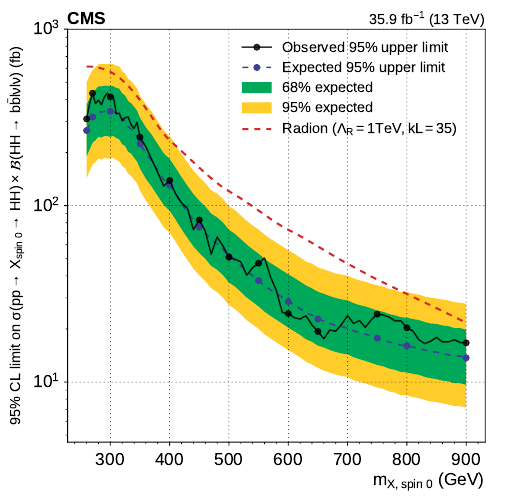
Figure 7 . Expected (dashed) and observed (continuous) 95% CL upper limits on the product of the production cross section for X and branching fraction for X ! HH ! bbVV ! bb ‘(cid:23)‘(cid:23) , as a function of m X . The inner (green) band and the outer (yellow) band indicate the regions containing 68 and 95%, respectively, of the distribution of limits expected under the background- only hypothesis. These limits are computed using the asymptotic CL s method, combining the e + e (cid:0) , (cid:22) + (cid:22) (cid:0) and e (cid:6) (cid:22) (cid:7) channels, for spin-0 (left) and spin-2 (right) hypotheses. The solid circles represent fully-simulated mass points. The dashed red lines represent possible cross sections for the production of a radion (left) or a Kaluza-Klein graviton (right), assuming absence of mixing with the Higgs boson [49]. Parameters used to compute these cross sections can be found in the legend.